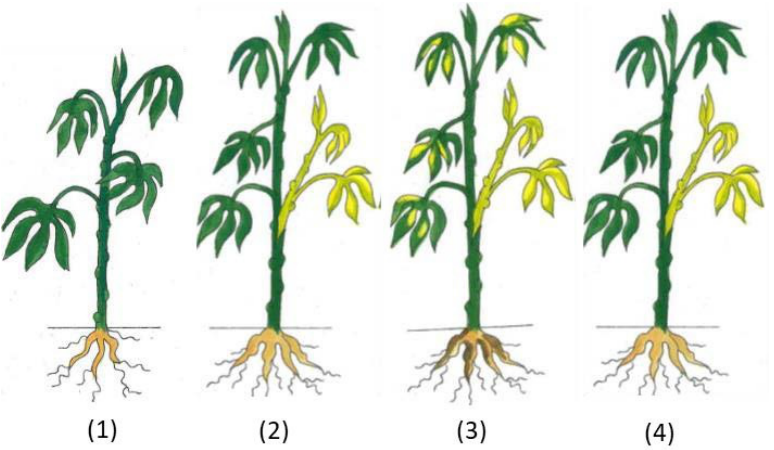
Figure 1. Introducing CBSV infections in 8-week-old cassava seedlings using scion grafting. Virus infections were introduced into cassava seedlings ( 1 ) by graft insertion of virus infected scions ( 2 ). A few weeks after grafting, typical symptoms for CBSV developing on leaves of rootstocks confirmed virus-susceptible seedlings ( 3 ), while the absence of symptoms in rootstocks indicated putative virus resistance ( 4 ).